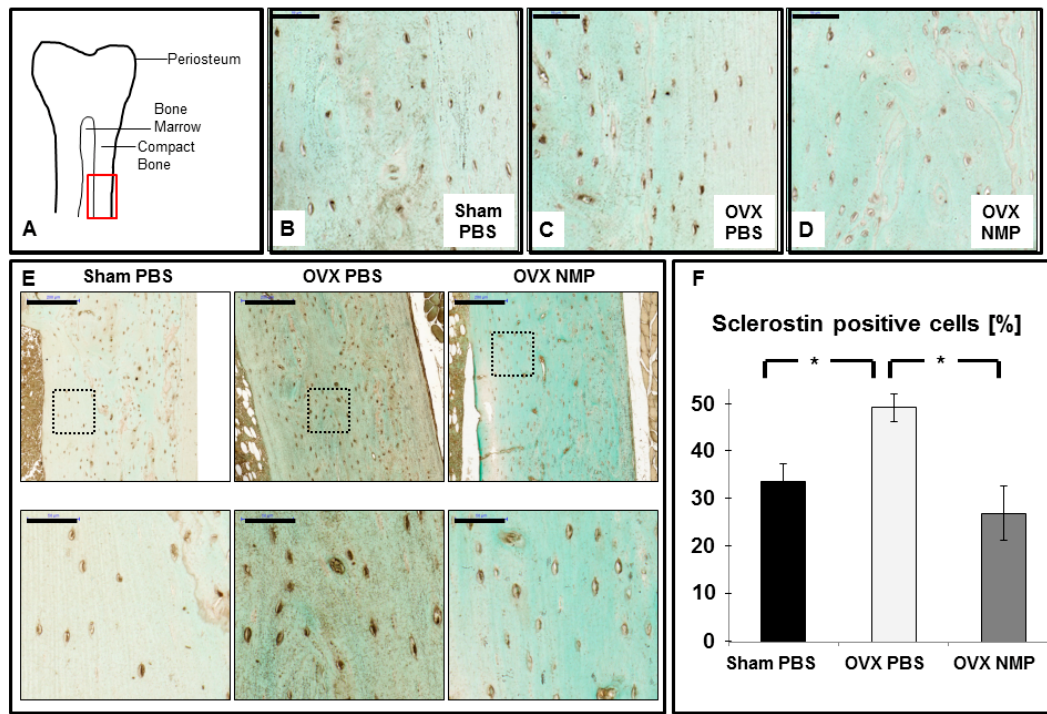
Figure 4. NMP prevents the osteoporosis induced increase in sclerostin expression. Female rats were subjected to ovariectomy (OVX) or control surgery (Sham) and treated with vehicle (PBS) or NMP and femurs were collected for histology. ( A ) Location of image acquisition of histological sections is marked by the red square. ( B ) Sham PBS animals with sclerostin producing osteocytes (brown color). ( C ) OVX animals injected with the vehicle control (PBS). ( D ) OVX animals injected with the chemical NMP. Scale bars in B-D represent 50 µ m. ( E ) High and low-magnifications of histological sections stained for sclerostin expression for all three groups as indicated: Sham PBS, OVX PBS and OVX NMP. Scale in the upper panel is 200 µ m and in the lower panel 50 µ m. The area of the histology of the lower panel is indicated in the respective upper panel by the dashed black rectangle. ( F ) Percentage of sclerostin positive cells. Stars indicate statistical significance at α = 0.05.